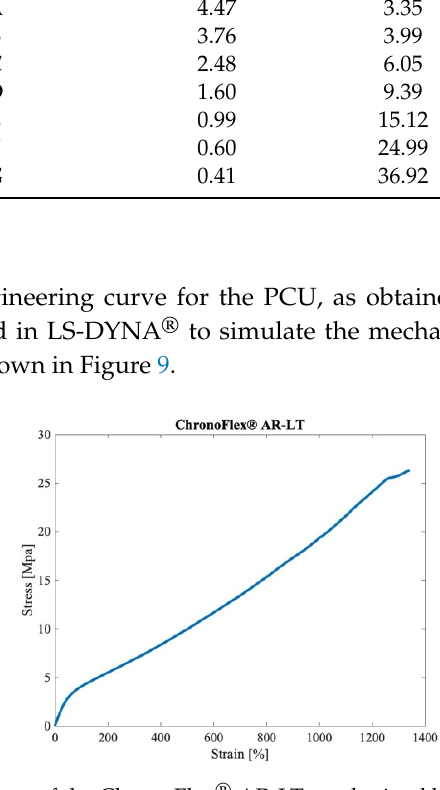
Figure 7. Convergence of the Von Mises stress versus the mesh density ratio.